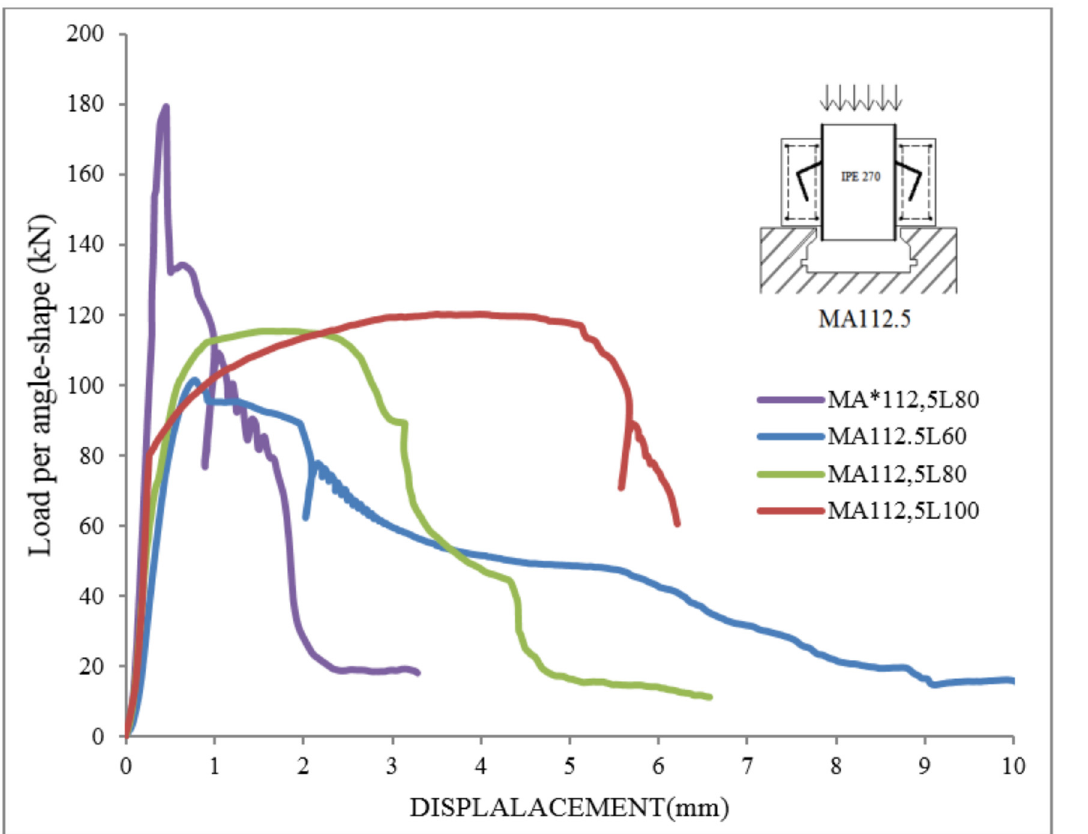
Fig 7. Load-displacement curves in specimens with tilt angle of